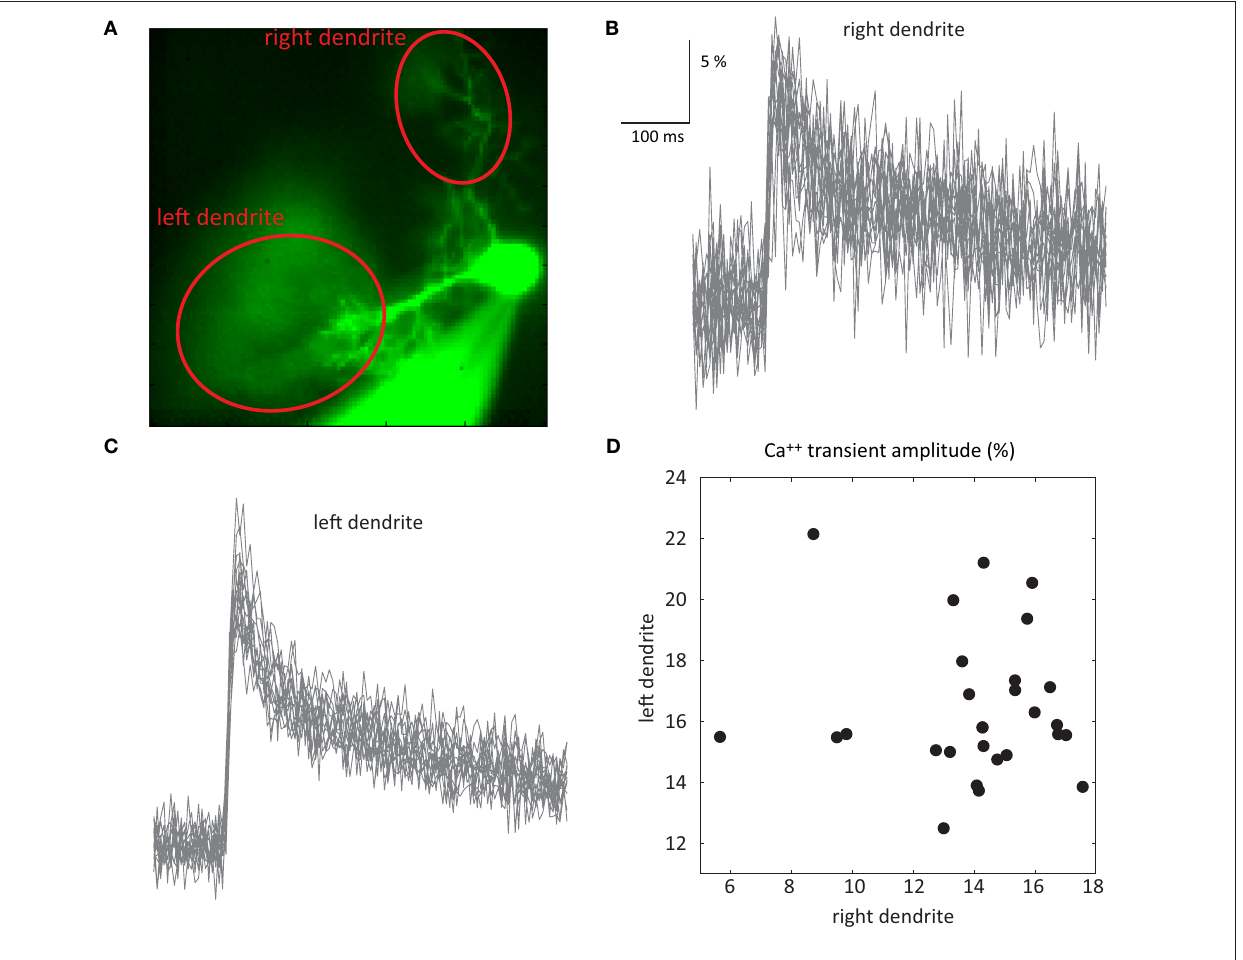
(C) dendrites (ROIs marked by the red ovals in (A) ; see Rokni and Yarom, 2009 for methods). (D) A scatter plot of the relationship between the amplitudes of the Ca ++ transients at the right and left